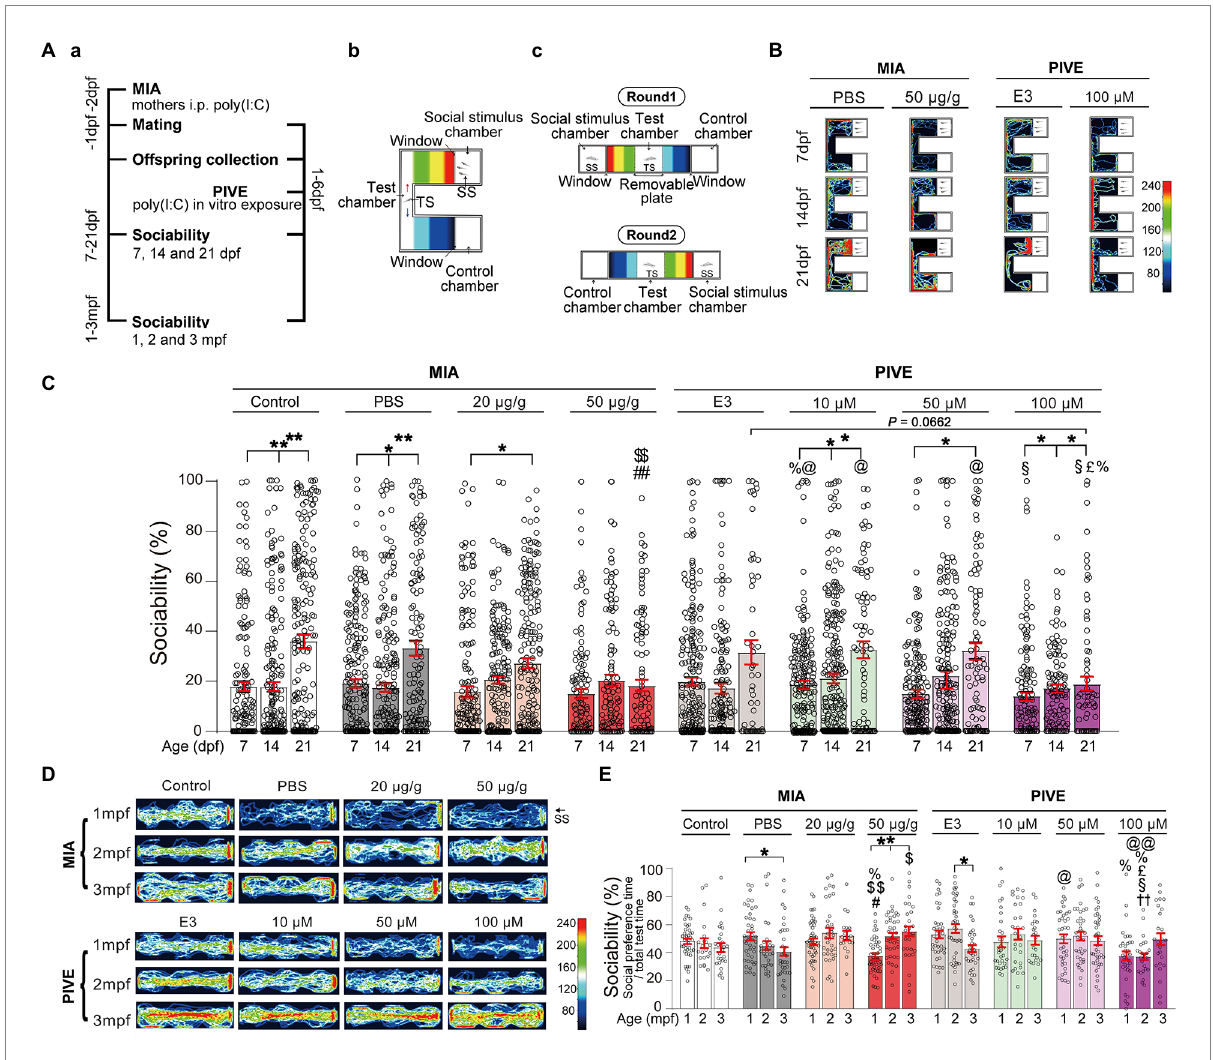
FIGURE 2 MIA offspring exhibited impaired social approach. (Aa) Zebrafish were tested for sociability (percentage of time spent investigating social object/ total test time spent) at 7, 14, and 21 dpf (Ab) , and 1, 2, and 3 mpf (Ac) after maternal poly(I:C) injection (MIA) or PIVE to fertilized embryos. (B) Video tracking of movements of MIA and PIVE larvae at 7, 14, and 21 dpf, showing the social interaction with social cue. (C) Sociability of MIA and PIVE larvae at 7, 14, and 21 dpf. MIA impaired the sociability at 21 dpf in 50 μ g/g group ( Z = 4.16 and 4.06, p < 0.01, compared to that of MIA-Control and MIA-PBS group, respectively); PIVE impaired the sociability at 21 dpf of 100 μ M group ( Z = 2.54, p = 0.07, compared to that of PIVE-E3 group). (D) Video tracking of movements of MIA and PIVE larvae at 1, 2, and 3 mpf, showing the social interaction with social cue. (E) Sociability of MIA and PIVE larvae at 1, 2, and 3 mpf. MIA decreased the sociability levels at 1 mpf of 50 μ g/g group ( Z = 3.59 and 3.99, p < 0.05 and 0.01, compared to that of MIA-Control and MIA-PBS group respectively); PIVE impaired the sociability at 2 mpf of 100 μ M group ( Z = 3.74, p < 0.01, compared to that of PIVE-E3 group). Data are presented as mean ± SEM. * p < 0.05, ** p < 0.001; # p < 0.05, ## p < 0.001 compared with the MIA-control group of the same age with social stimulus; $ p < 0.05, $$ p < 0.001 compared with the MIA-PBS group of the same age with social stimulus; % p < 0.05 compared with the